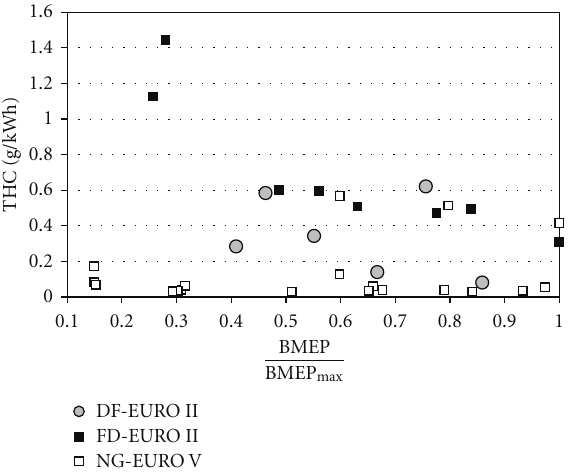
Figure 7: NO x emission for DF, FD and full NG engines measured in the condition of Figure